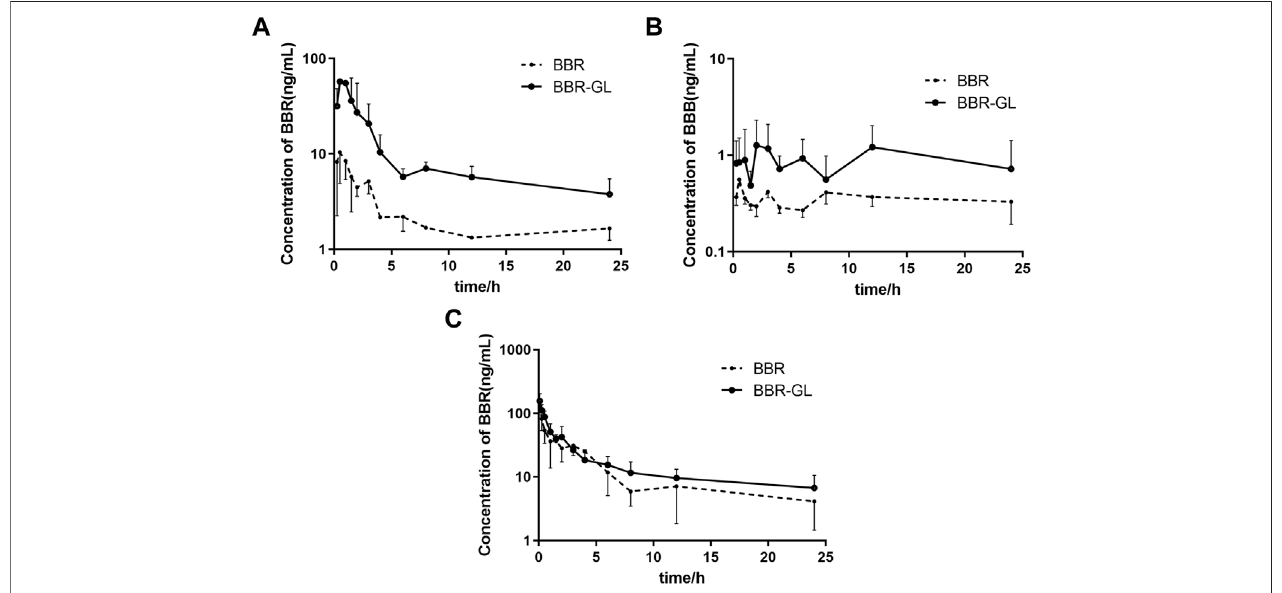
FIGURE 5 | Mean plasma concentration – time curves in rats of (A) BBR, (B) BBB following oral administration, and (C) BBR following intravenous injection of BBR and BBR-GL. Data are presented as mean ± SD.